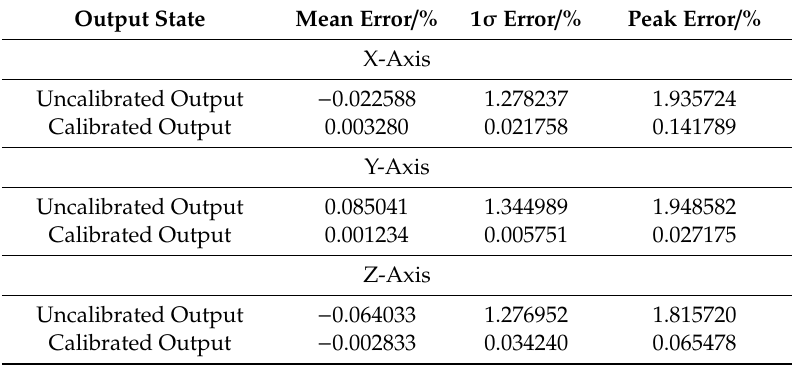
Table 3. Tabulation of the reduction in percentage errors obtained for all axes upon calibration application.